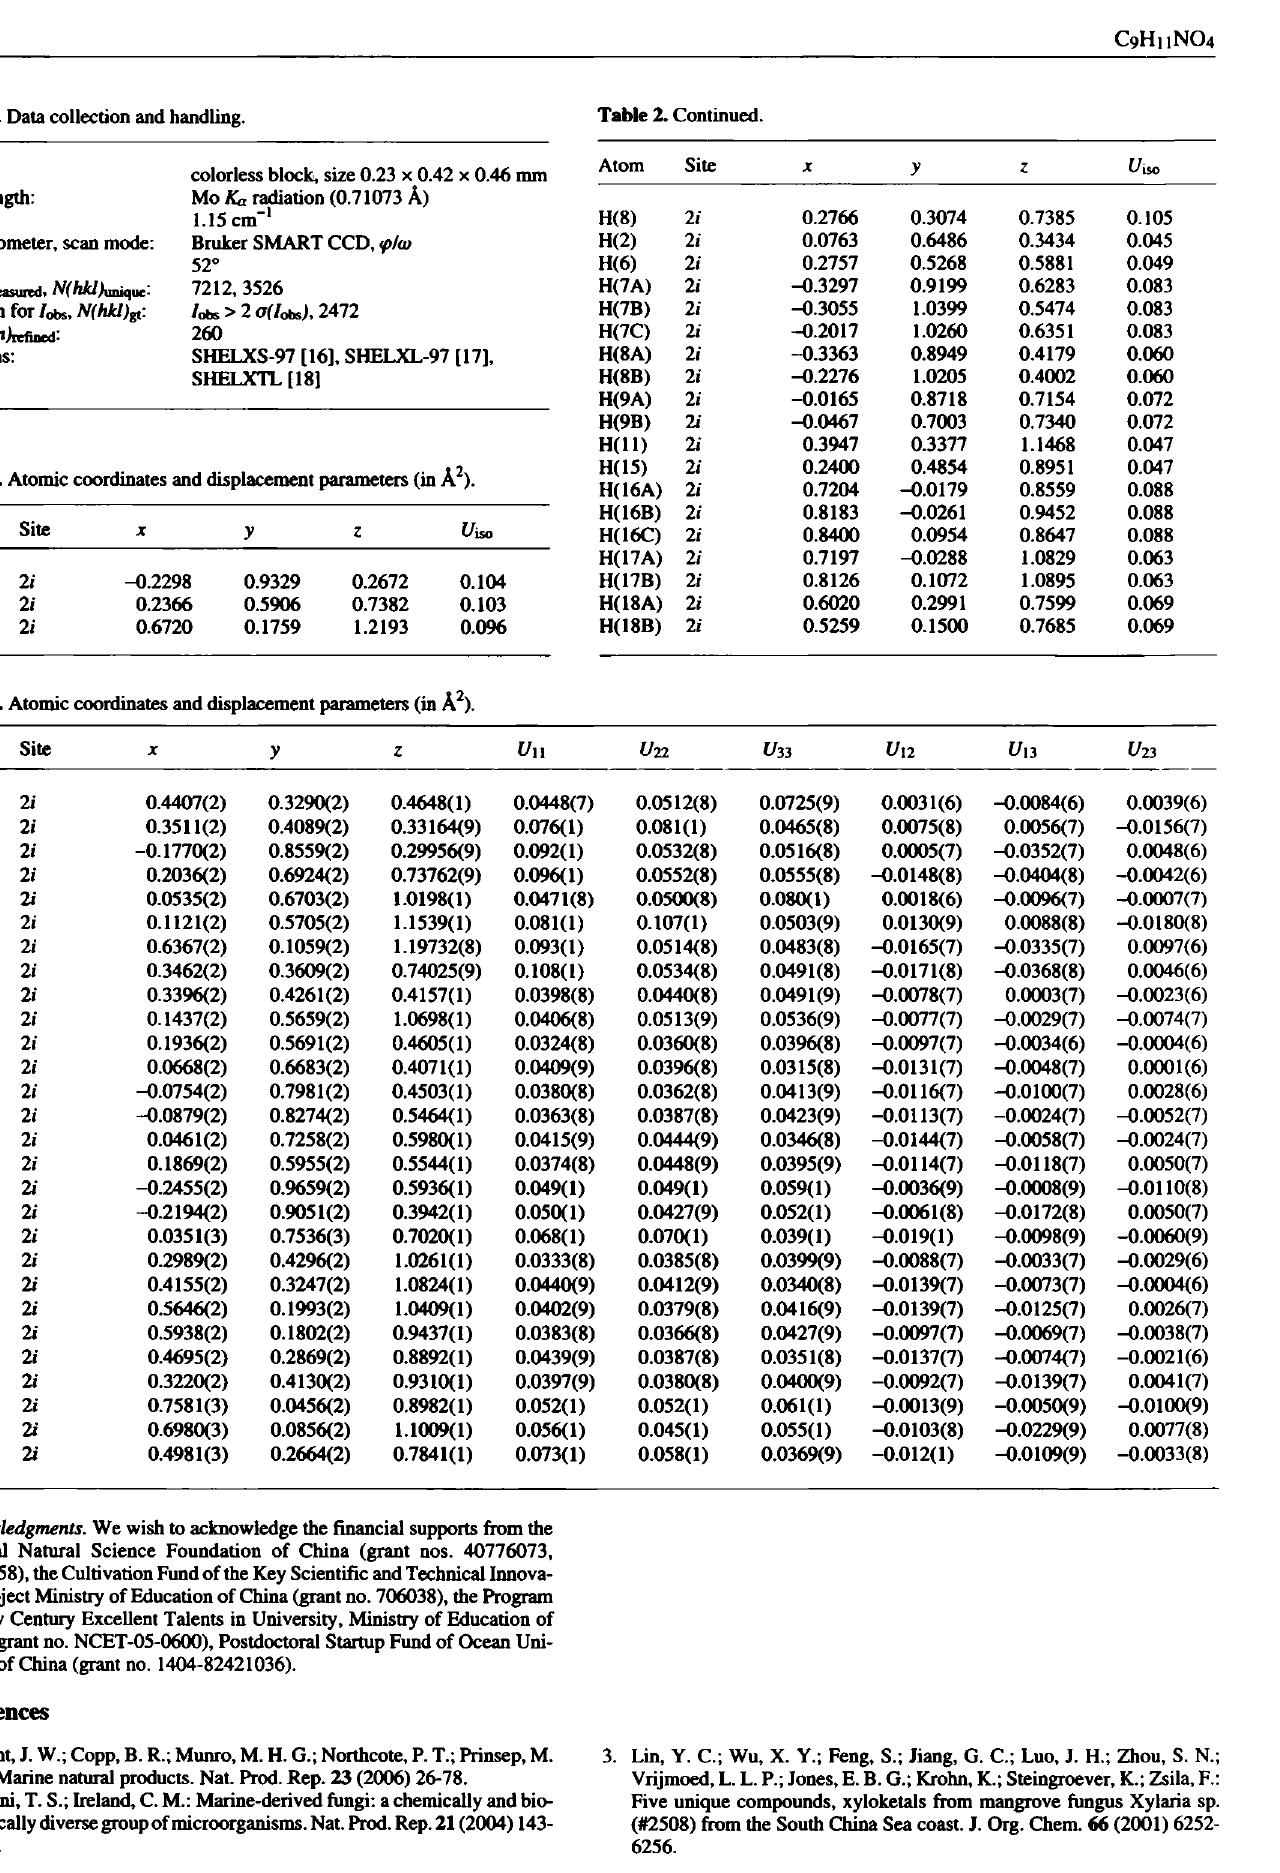
Table 2. Atomic coordinates and displacement parameters (in Â 2 ).